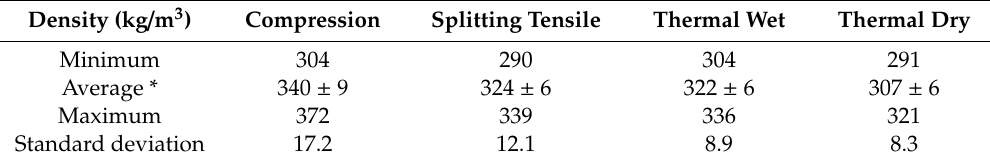
Figure 1. Average densities of all hempcrete samples. Table 2. Descriptive statistics of samples.